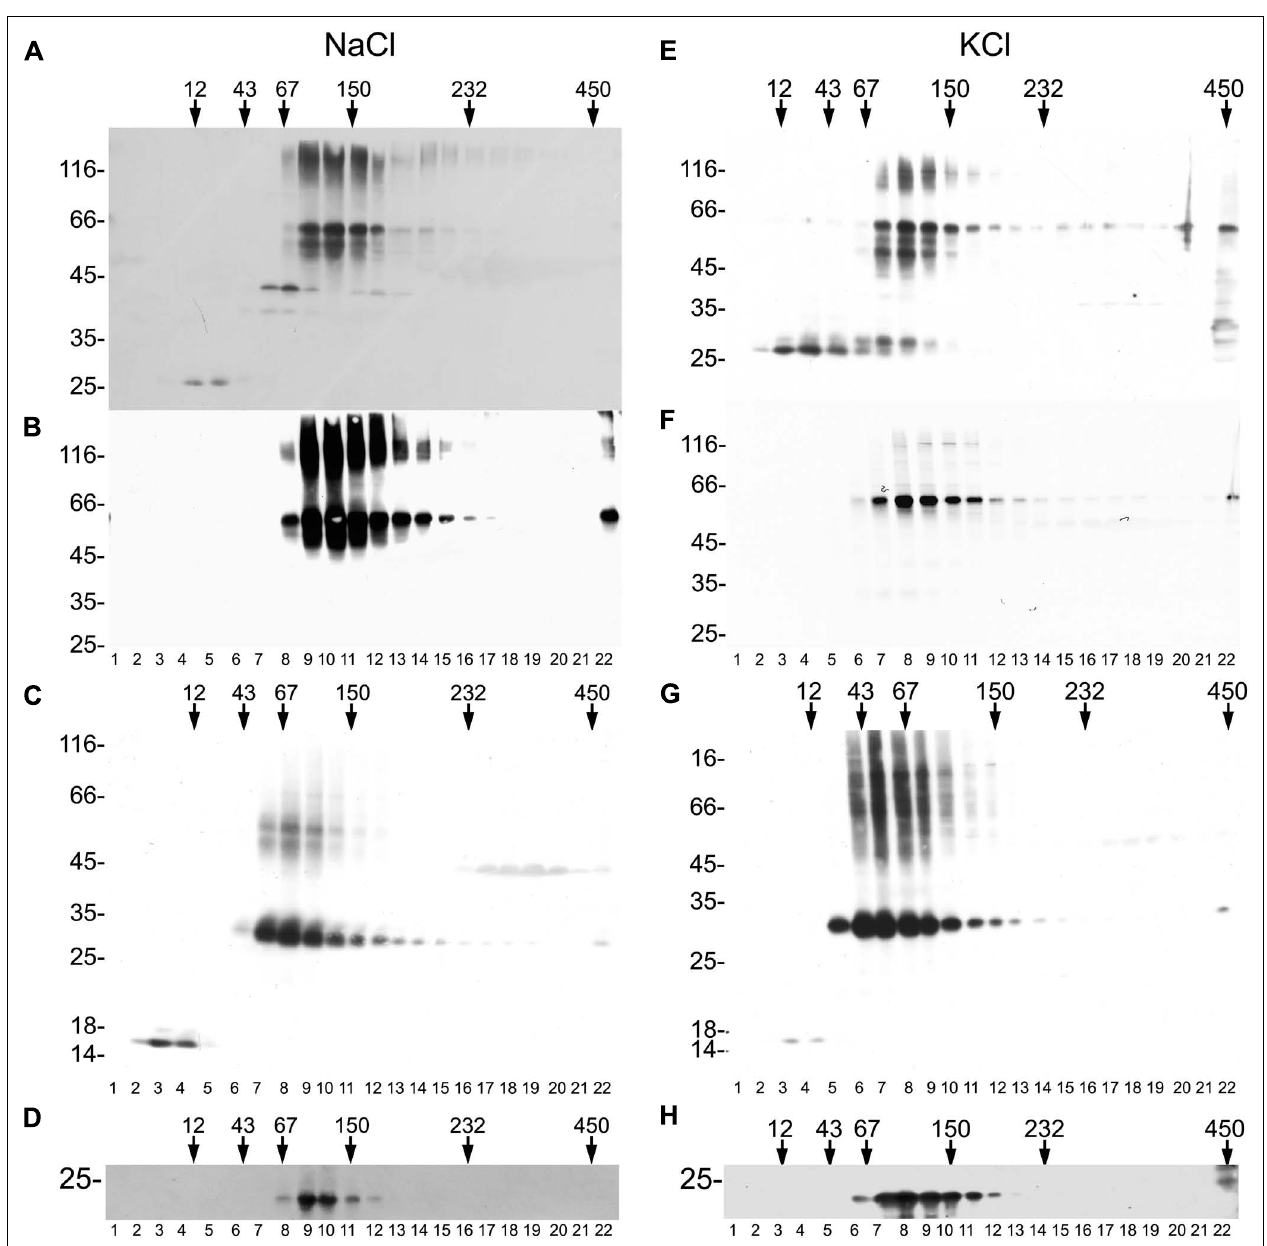
FIGURE 7 | KCO3::GFP and KCO3 are dimers. Leaves from KCO3::GFP (A,B,D–F,H) or KCO3 (C,G) transgenic Arabidopsis plants were homogenized in the presence of non-ionic detergent and either 200 mM NaCl (A–D) or 40 mM KCl (E–H) .The homogenates were then subjected to sedimentation velocity centrifugation on a continuous 5–25% (w/v) sucrose gradient. One-tenth of the total volume of each gradient fraction were analyzed by